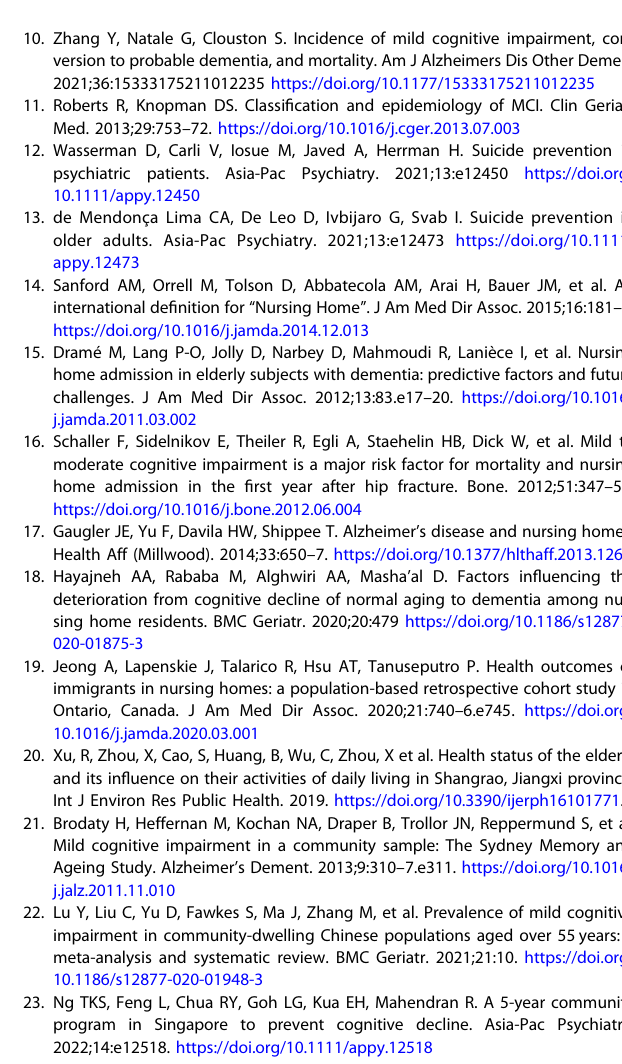
Fig. 3 Publication bias of included studies on the prevalence of MCI. Funnel plot was plotted by random effects. MCI mild cognitive